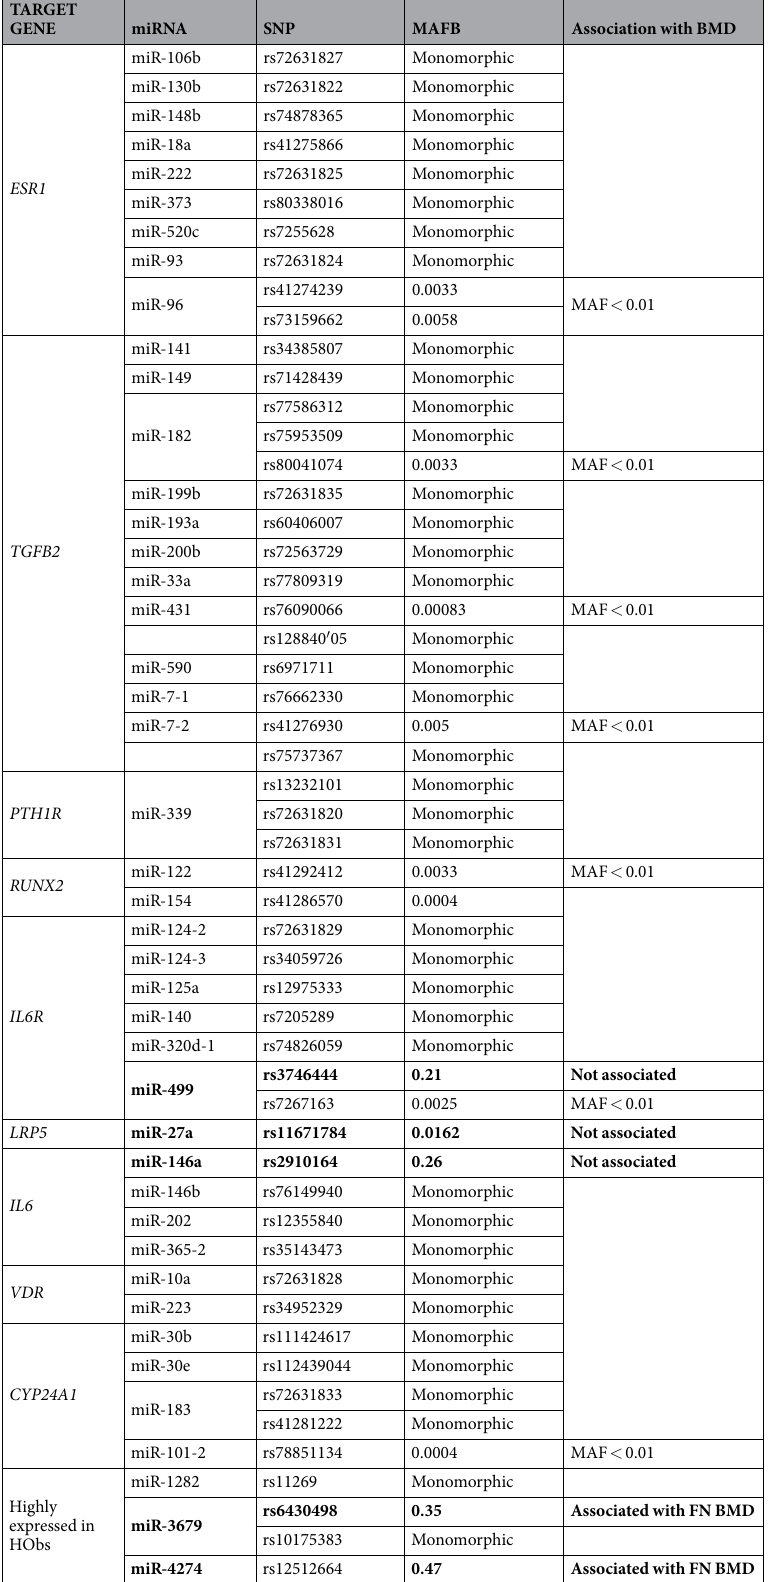
Table 1. Validation of miR-SNPs for the BMD association analysis. MAFB; Minor allele frequency in BARCOS cohort; SNPs with MAF < 0.01 were excluded for genotyping. In bold; Validated SNPs for genotyping in total OSTEOMED2